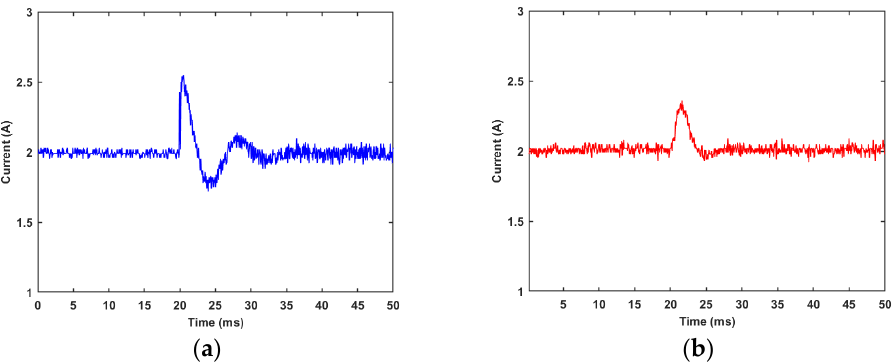
Figure 16. Responses of different controllers under the disturbance of damper parameters (2 A): ( a ) PI controller; ( b ) fuzzy PI controller.